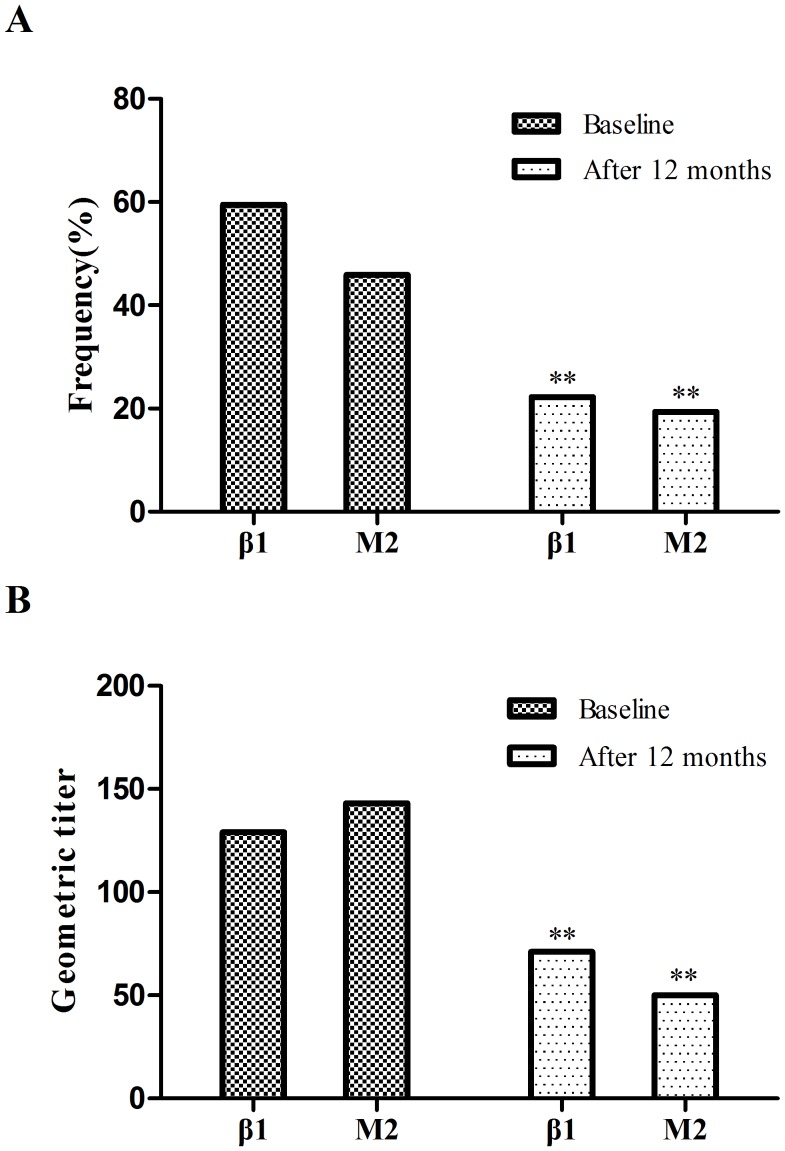
The comparison for frequency and geometric titers of autoantibody between baseline and after 12-month treatment.After 12-months treatment, the frequency and geometric titers of both β1R-AABs and M2R-AABs were decreased significantly (P<0.001).